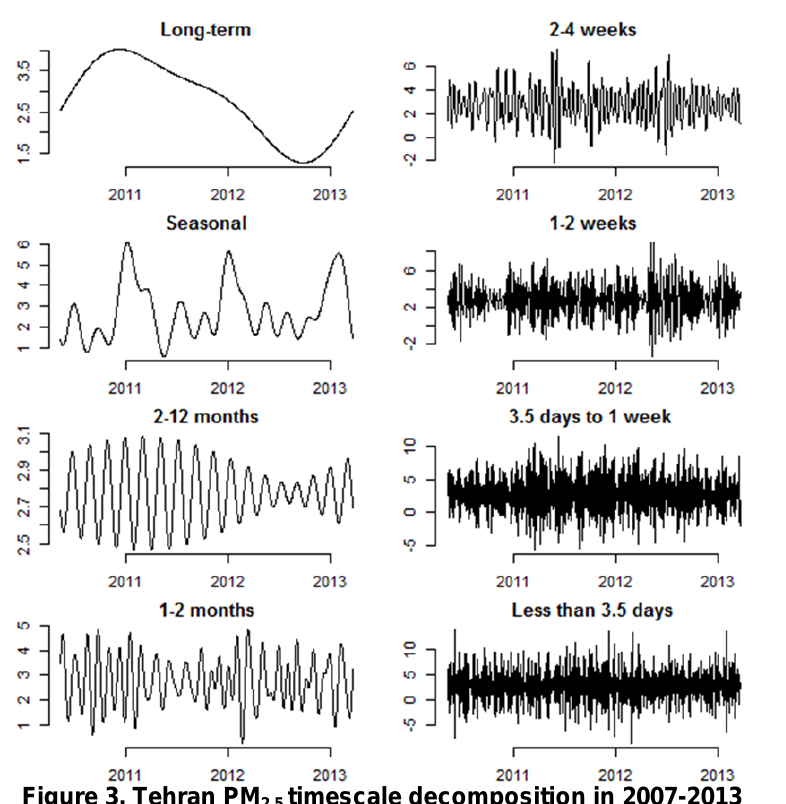
Figure 3. Tehran PM